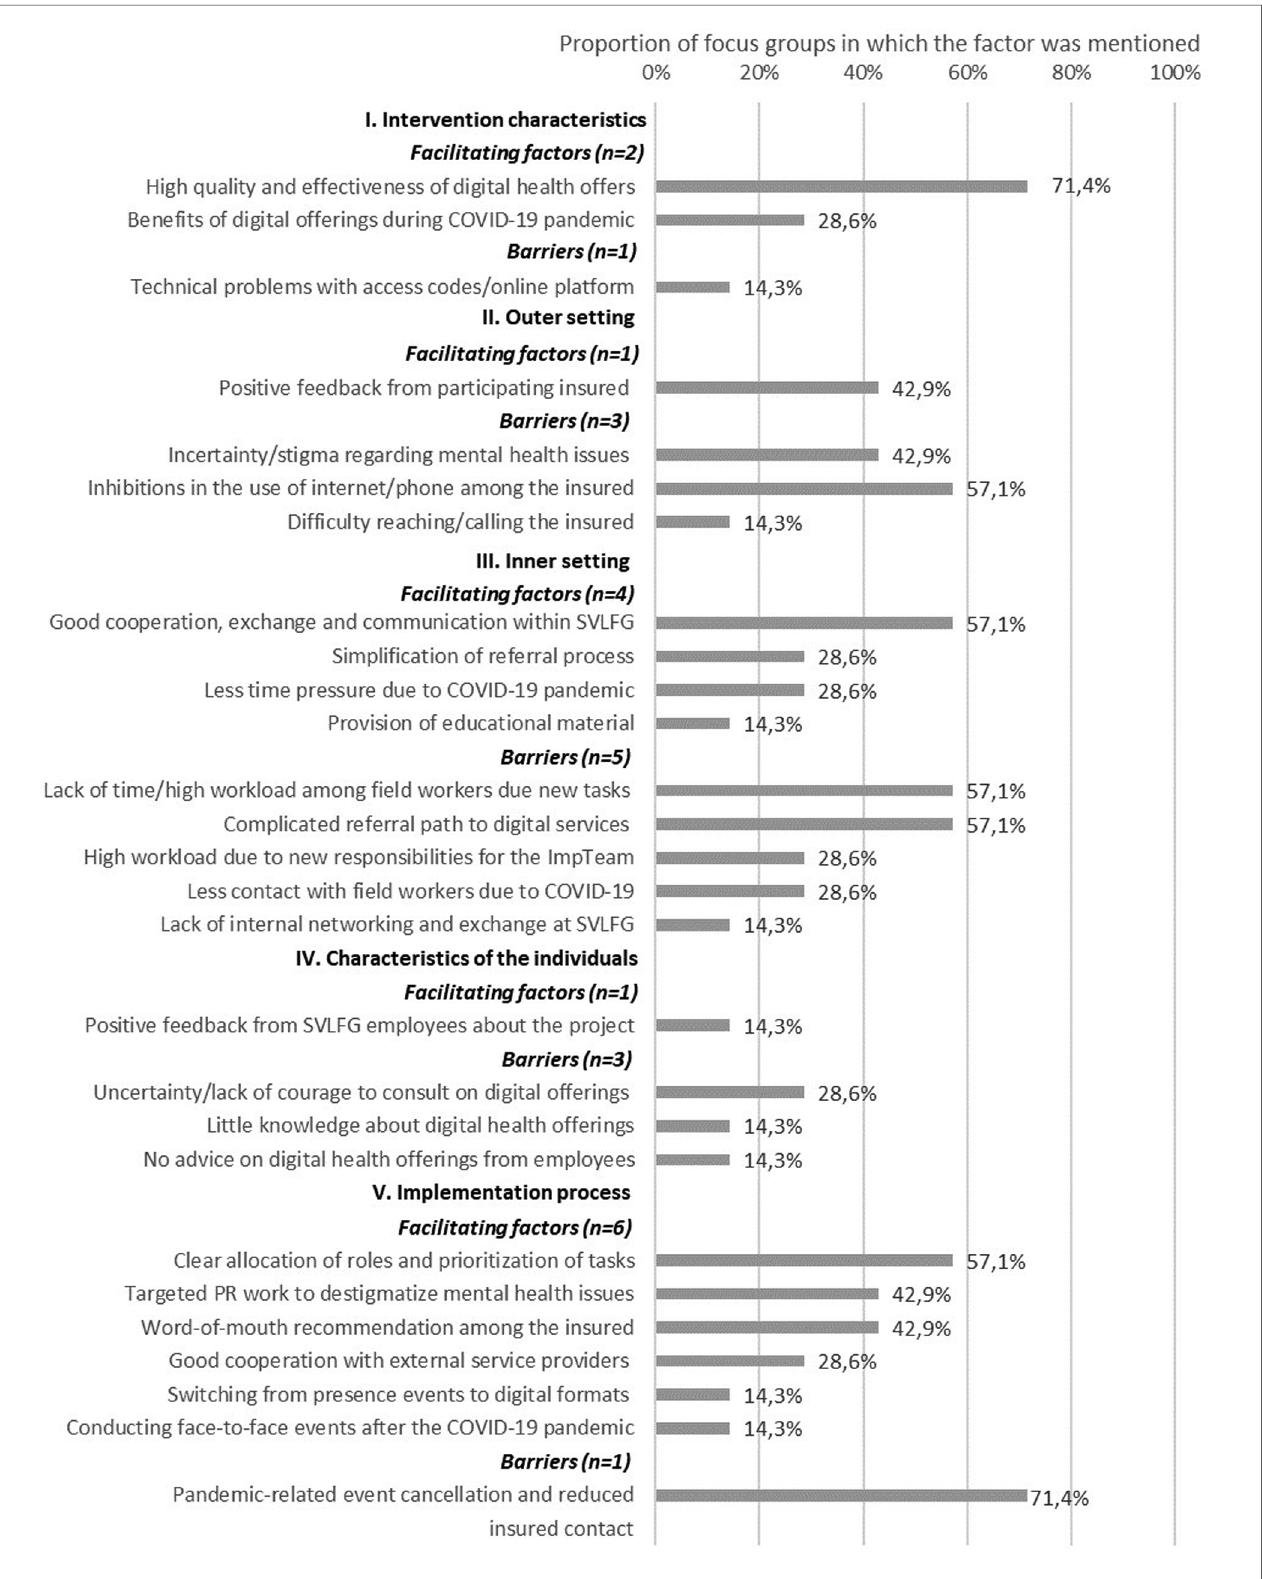
FIGURE 3 Barriers and facilitating factors from the perspective of the implementation team ( n =7) on implementation determinants based on fi ve CFIR